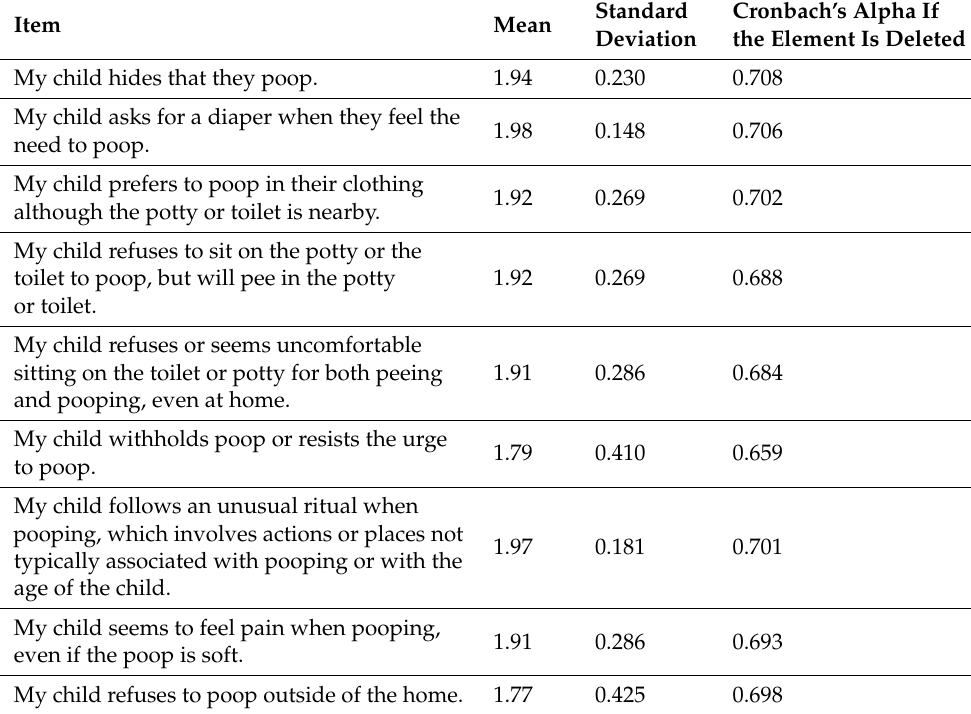
Table 3. Internal consistency: Cronbach’s alpha for the subscales and Cronbach’s alpha if item